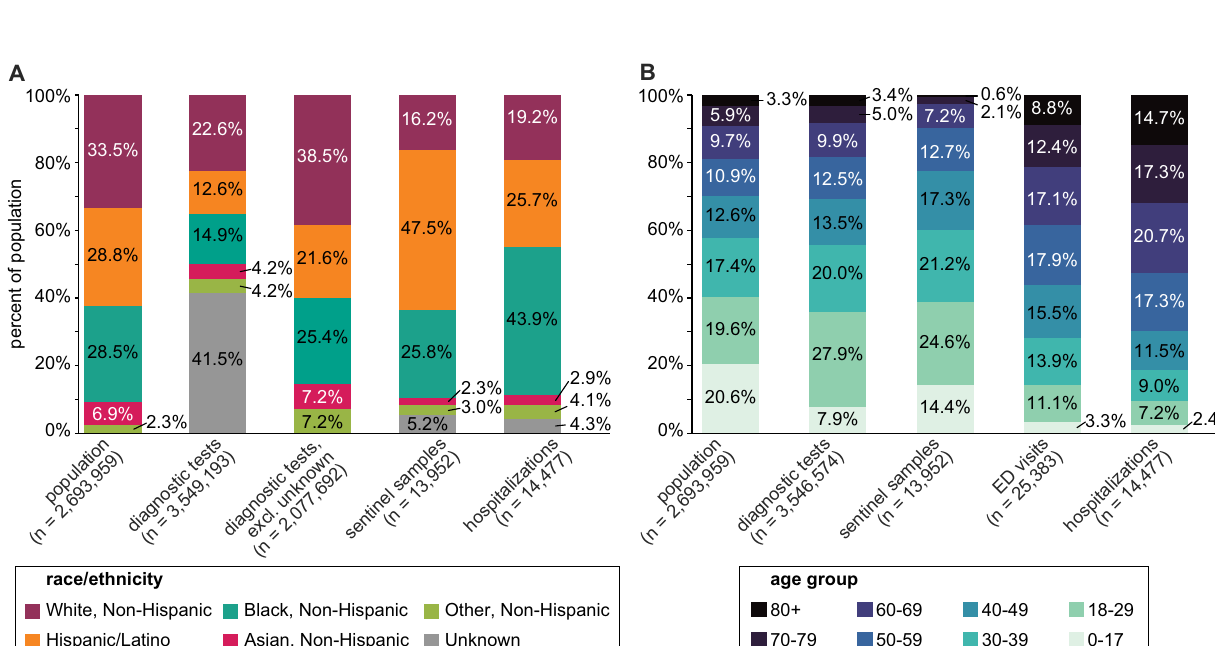
Fig. 2 | Locations and volume of outpatient sentinel surveillance in Chicago fromSeptember27,2020,toJune13,2021.A Staticsentineltestingsitelocations in Chicago. Letter labels correspond to site names in panel C . Colors indicate the percentage of eachZIP area ’ s residents who are Hispanic/Latino (leftmap) or Non-